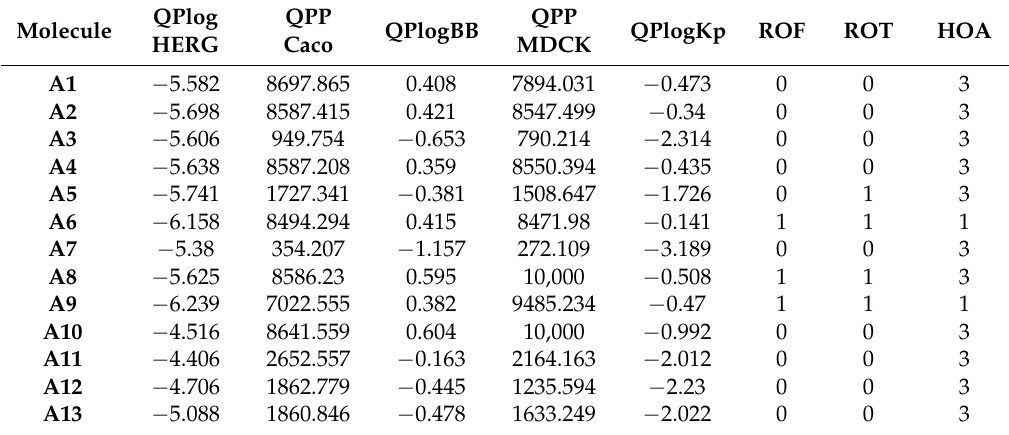
Table 3. Pharmacokinetic properties calculated of compounds A1 – 13